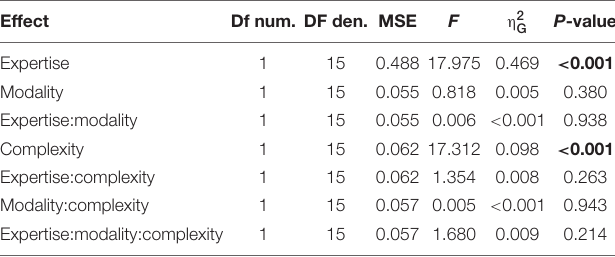
TABLE 1 | Repeated measure ANOVA—JND (experiment 1).